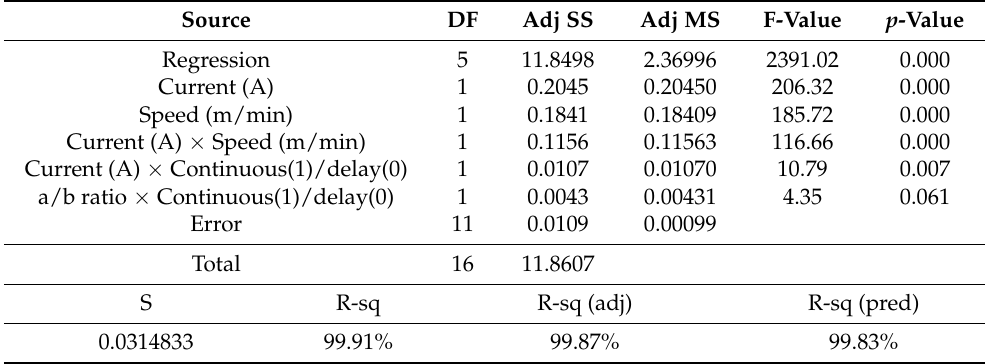
Table 6. ANOVA for